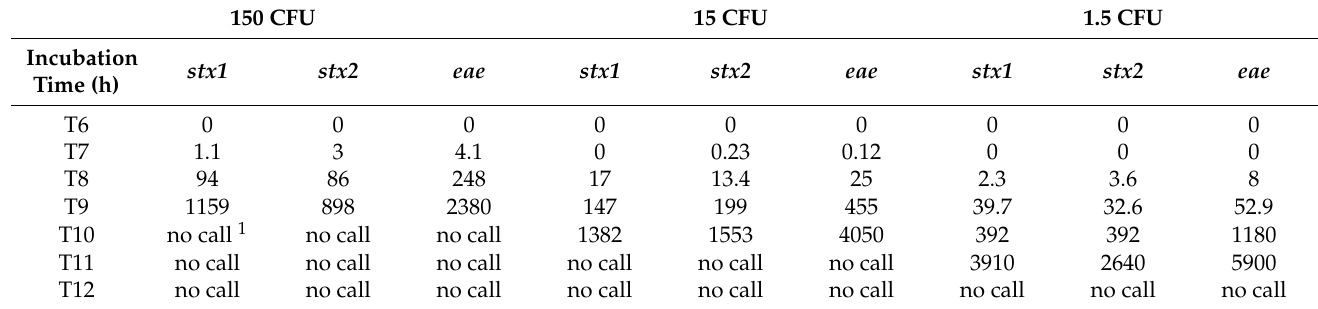
Table 3. Number of copies/ µ L detected by droplet digital PCR in sponges artificially contaminated with different concentrations of E. coli O157:H7 (150, 15, and 1.5 CFU/mL) and incubated at 37 ◦ C for different